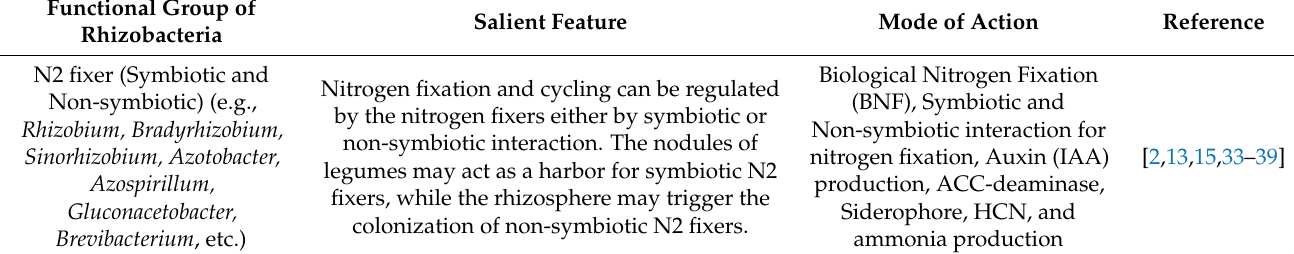
Table 1. Functional groups of beneficial rhizobacteria with their salient feature and mode of action toward sustainable improvement of soil health. Salient Feature Mode of Action